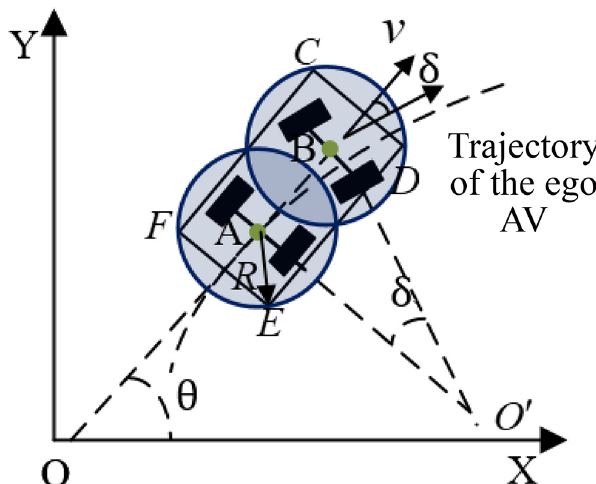
Figure 3 Vehicle